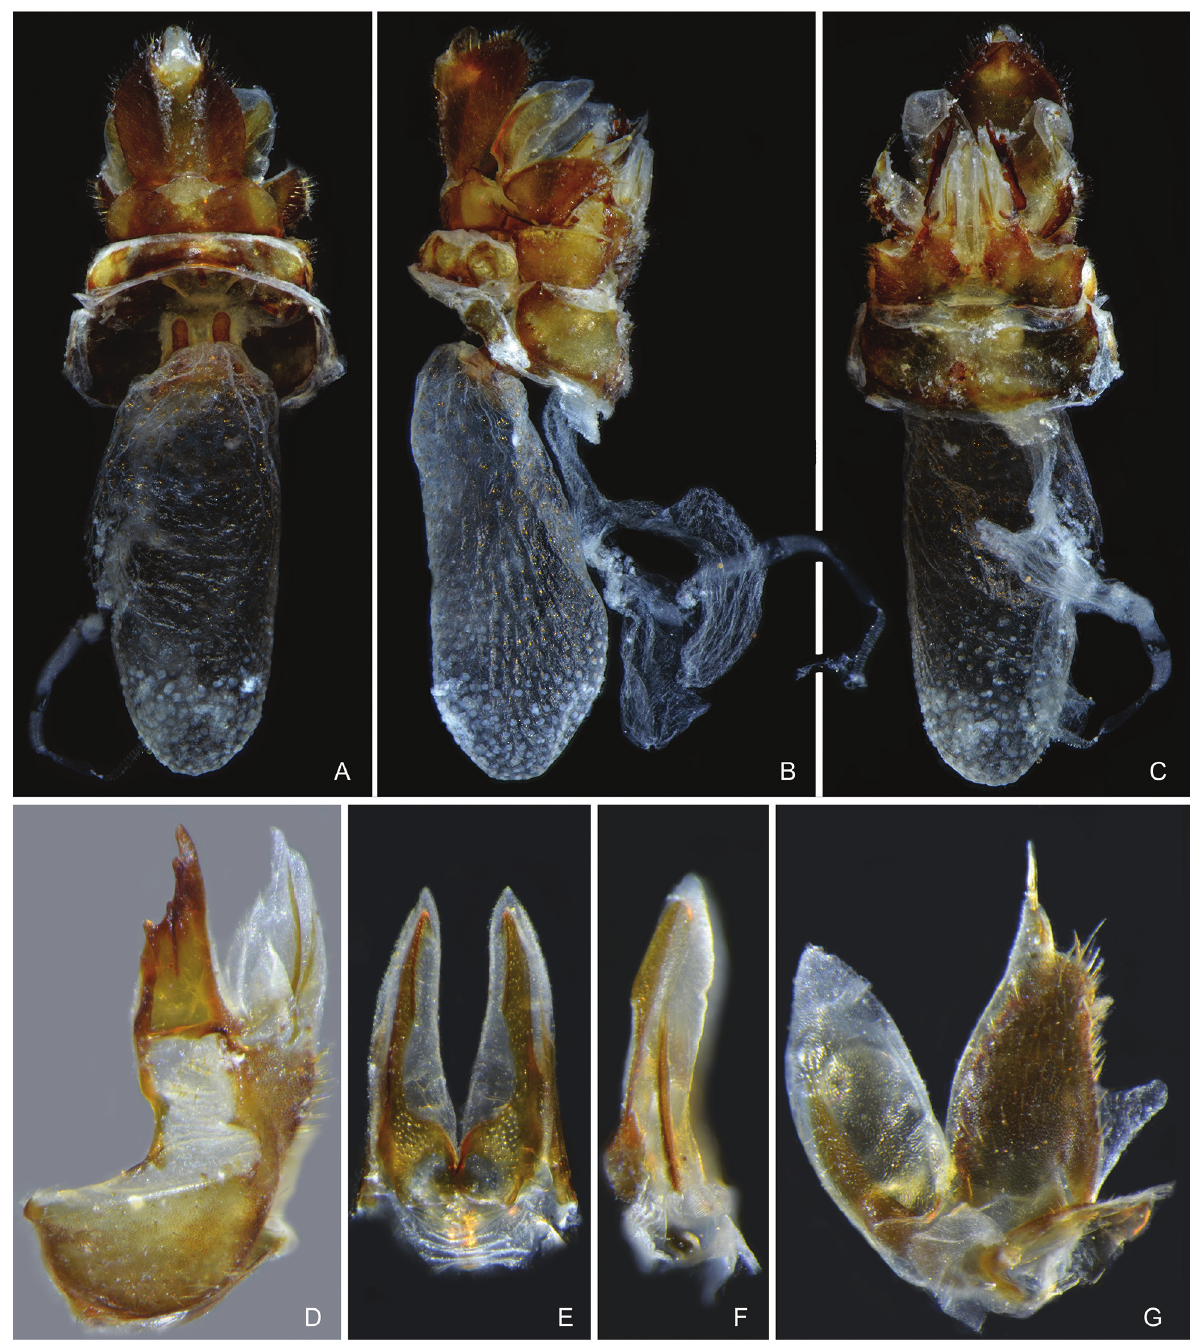
Figure 7. Orthopagus hainanensis sp. n. ( A ) Female terminalia and ectodermal genital ducts, dorsal view. ( B ) Female terminalia and ectodermal genital ducts, lateral view. ( C ) Female terminalia and ectodermal genital ducts, ventral view. ( D ) Gonapophysis VIII, dorsolateral view. ( E ) Gonapophysis IX, ventral view. ( F ) Gonapophysis IX, lateral view. ( G ) Gonoplacs, lateral